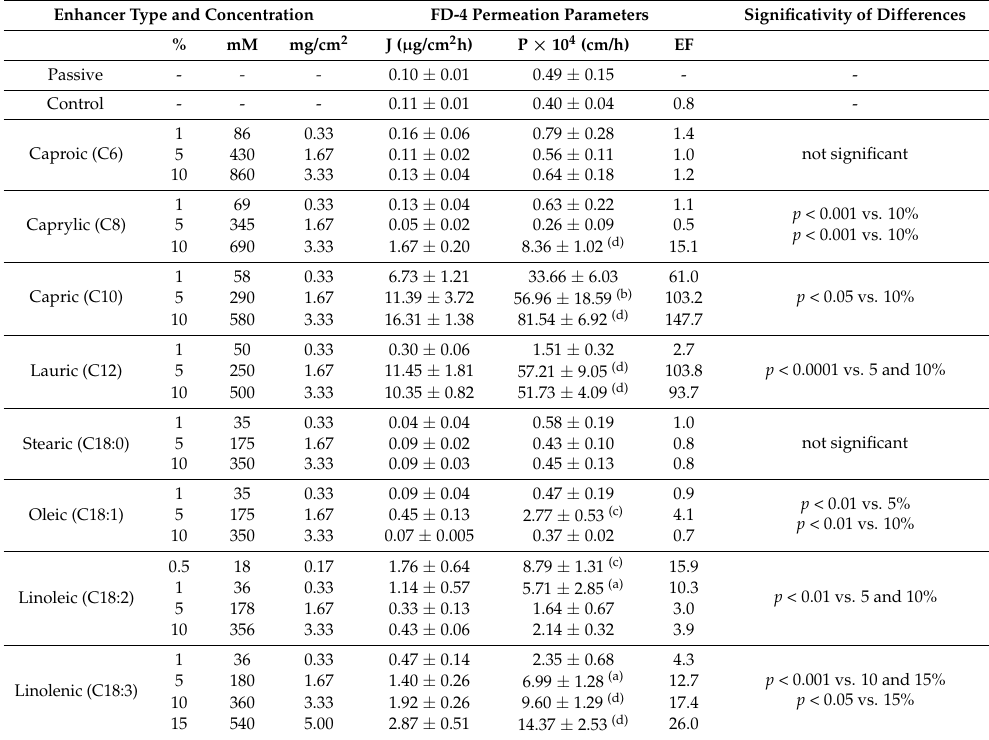
Table 2. Effect of type and concentration of fatty acid on the permeation parameters of FD-4 across pig esophageal epithelium (mean values ± SEM). Enhancer Type and Concentration FD-4 Permeation